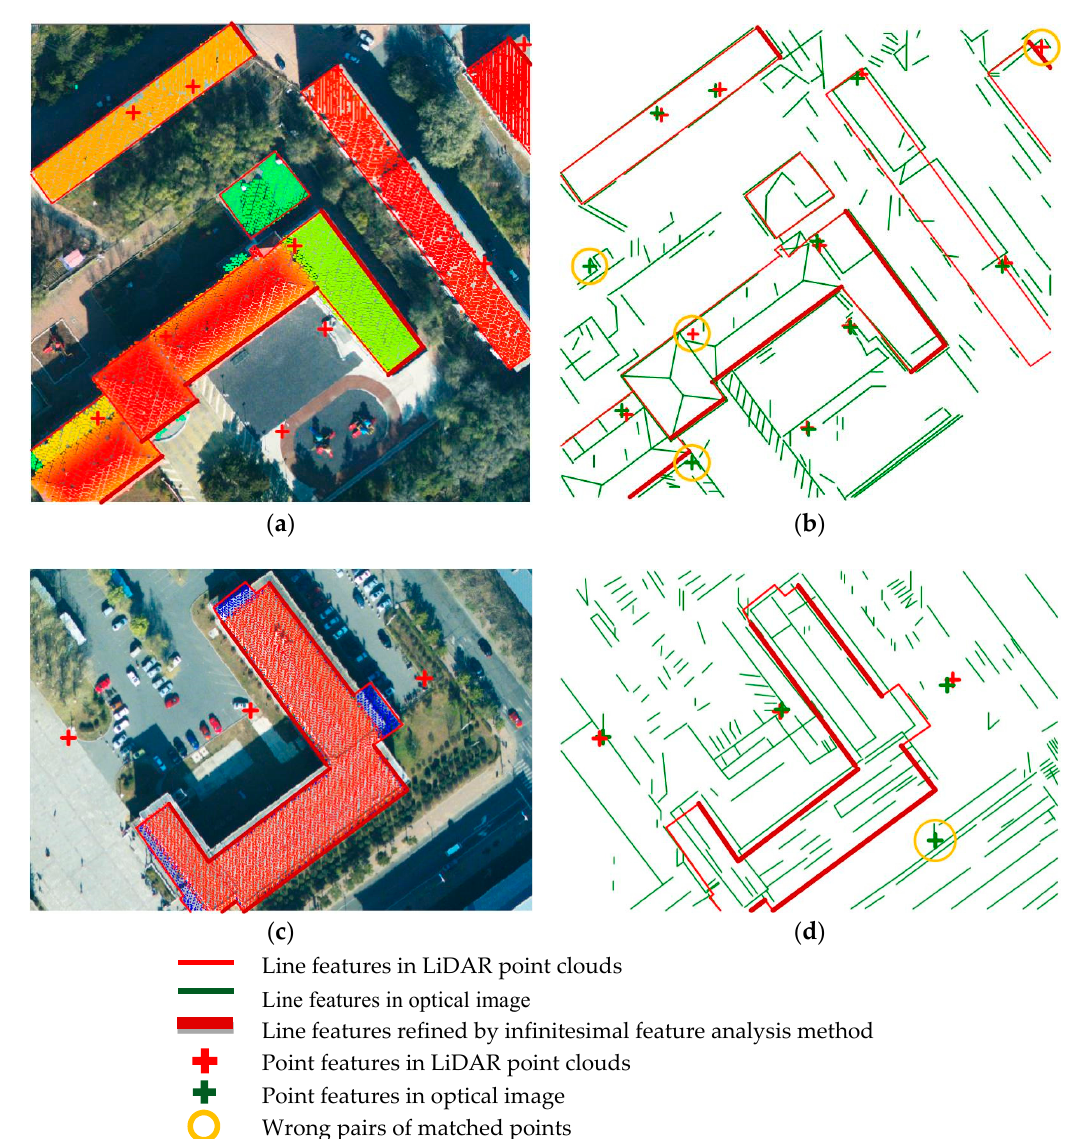
Figure 8. Extracted lines and points: ( a ) and ( b ) show the features extracted from LiDAR data; while ( c ) and ( d ) show the features extracted from optical images.